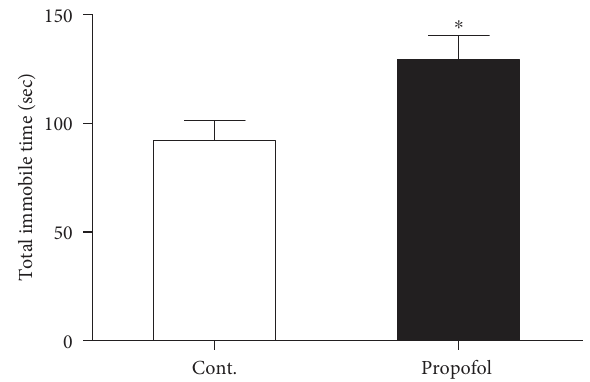
Figure 1: Propofol increased the total immobile time of mice compared to control mice in the tail suspension test. All data are expressed as the means ± SEM . n = 10 . ∗ p < 0 05 .